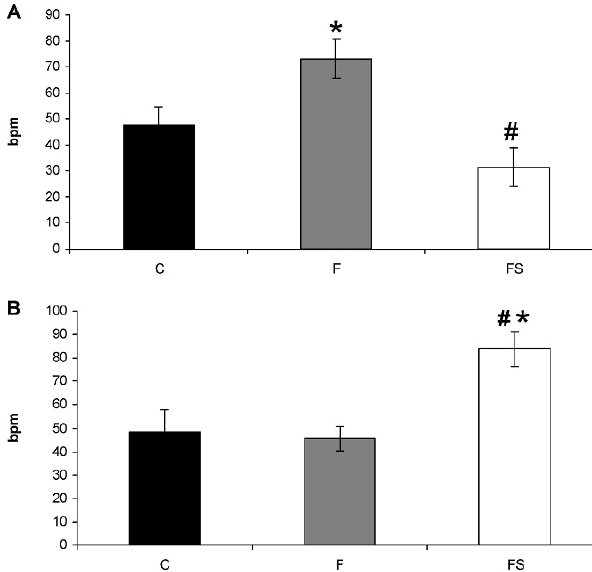
Figure 1 - A ) The sympathetic effect and B ) the vagal effect in the control (C), fructose (F), and fructose + simvastatin (FS) groups. * p , 0.05 vs. the C group; # p , 0.05 vs. the F